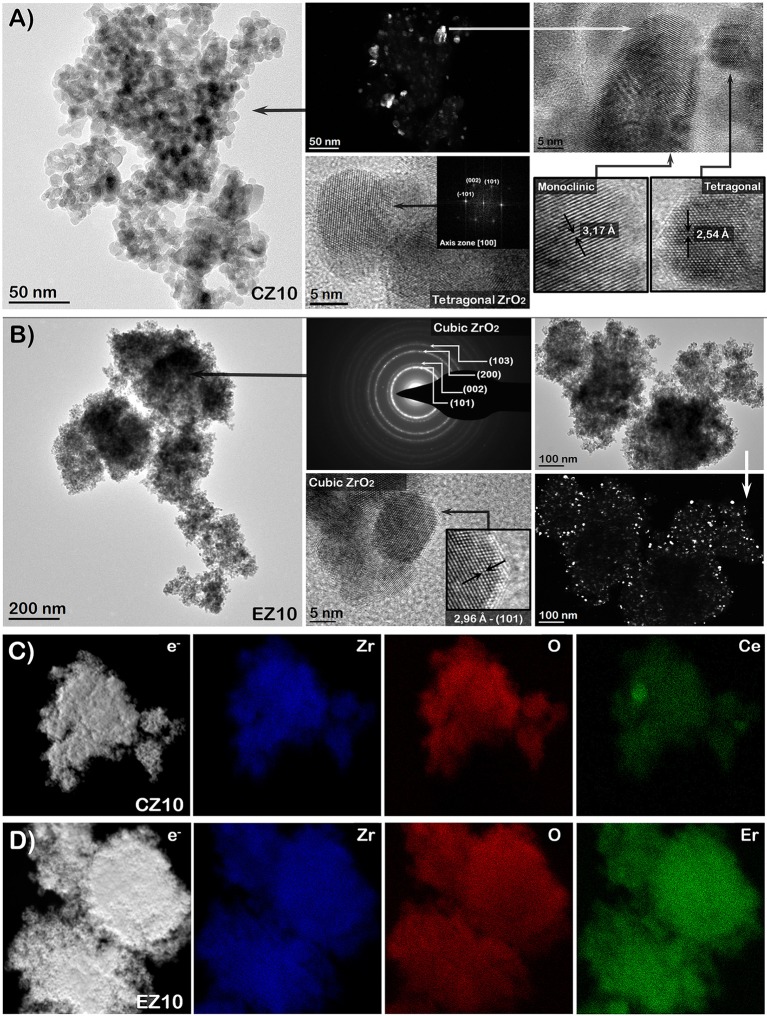
(A,B) TEM (left column) and HR-TEM (center and right columns) images and (C,D) STEM images with EDS maps of RE-doped samples with 10 mol % of Ce and Er: CZ10 (A,C) and EZ10 (B,D), respectively.